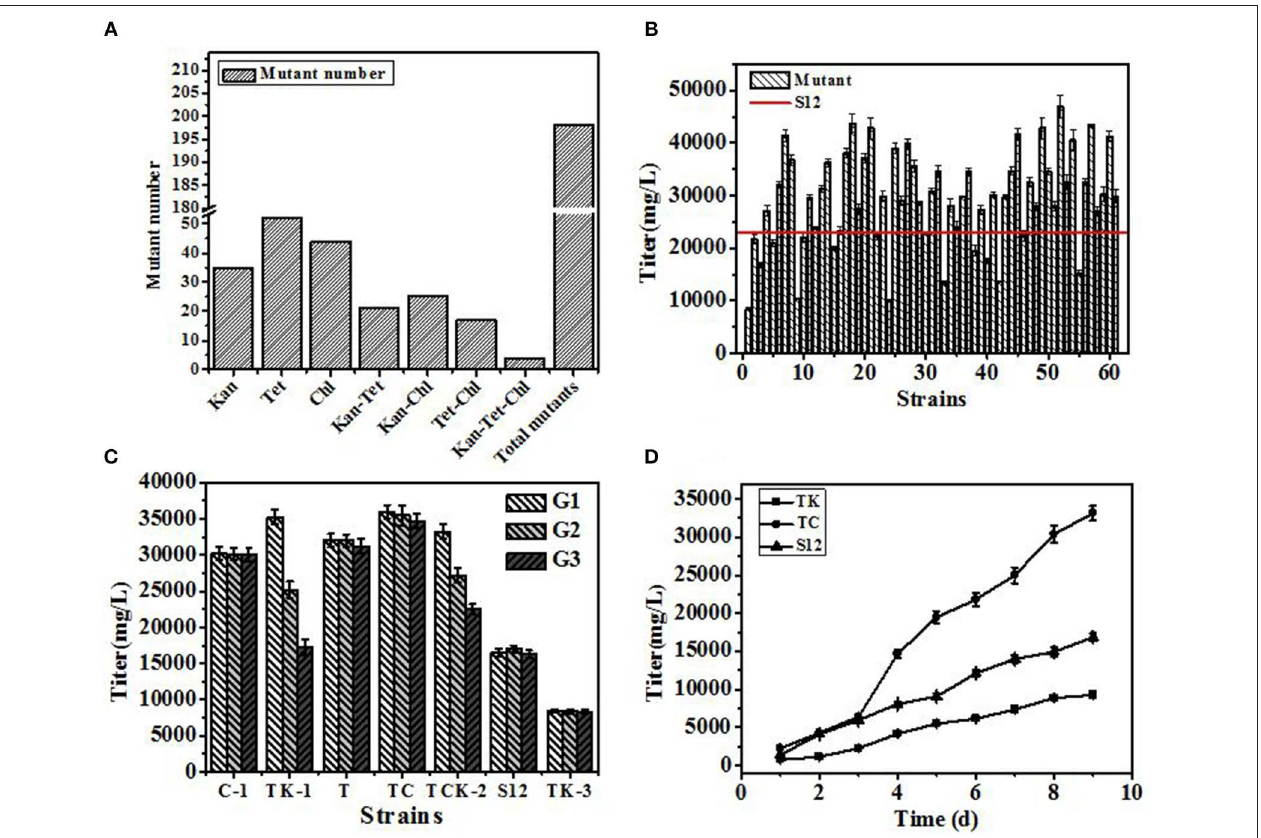
FIGURE 3 | The results of the developed breeding process. (A) Number of mutants selected in resistance screening. (B) Titer of salinomycin production by mutants grown in shaking flask culture. (C) Genetic stability of selected mutants after 3 generations. (D) Titer of salinomycin production by mutants TK, Tet 30 Chl 25 , and the initial strain S12 grown in shaking flask culture. Error bars indicate standard error of the mean.